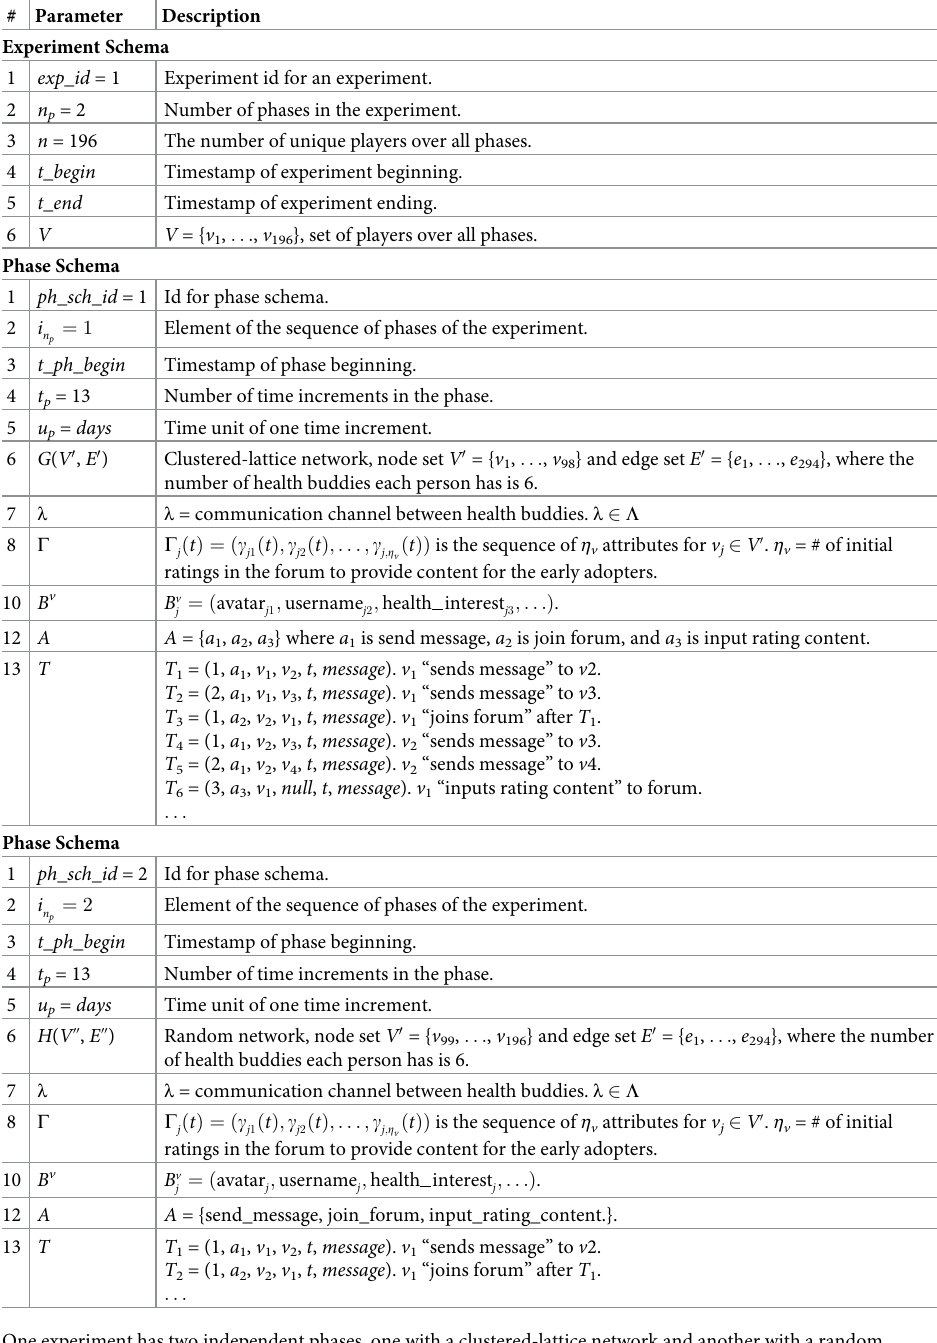
Table 14. Online social network experiment in [3], defined with our data